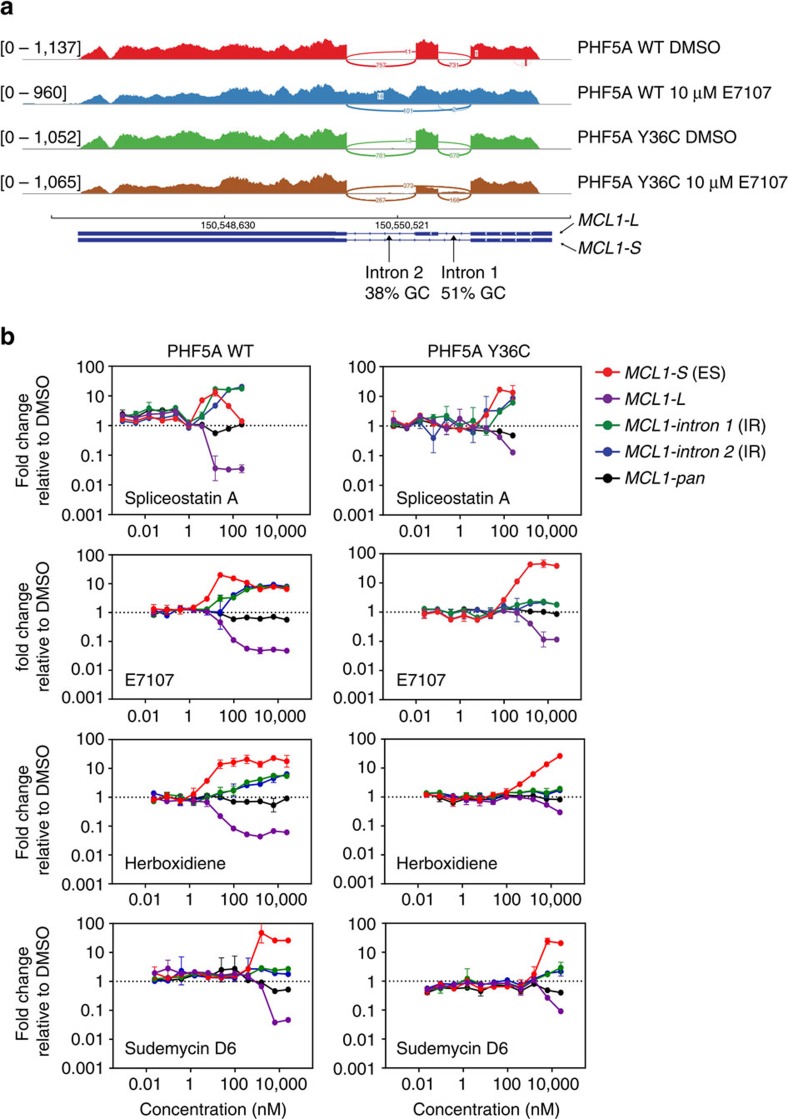
PHF5A-Y36C alters the effects of splicing modulators on MCL1 splicing.(a) Representative Sashimi plot of the production of different MCL1 isoforms under indicated treatment from either WT or Y36C PHF5A overexpressing cells. Total reads for each track are shown in the left. (b) Taqman gene expression analysis of indicated MCL1 isoforms in either WT (left panel) or Y36C (right panel) PHF5A expressing cells treated with splicing modulators. Error bar indicates s.d., n=2.